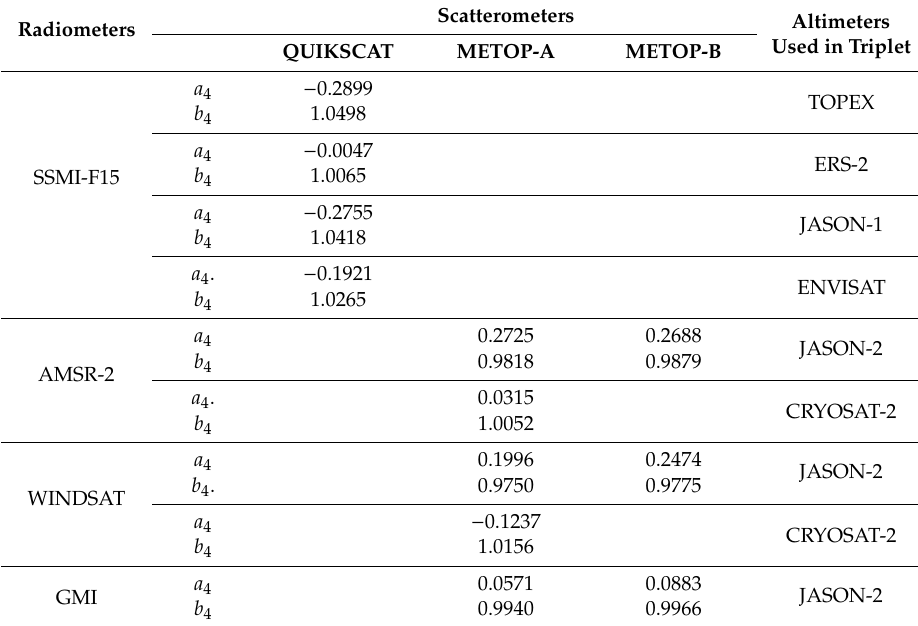
Table 4. Calibration coe ffi cients slope ( b 4 ) and o ff sets ( a 4 ) for intercalibrations between scatterometers ( X ) and radiometers ( X ) wind speed in which radiometer is the reference. Empty cells mean no 2 3 calibration has been performed. All other parameters as noted